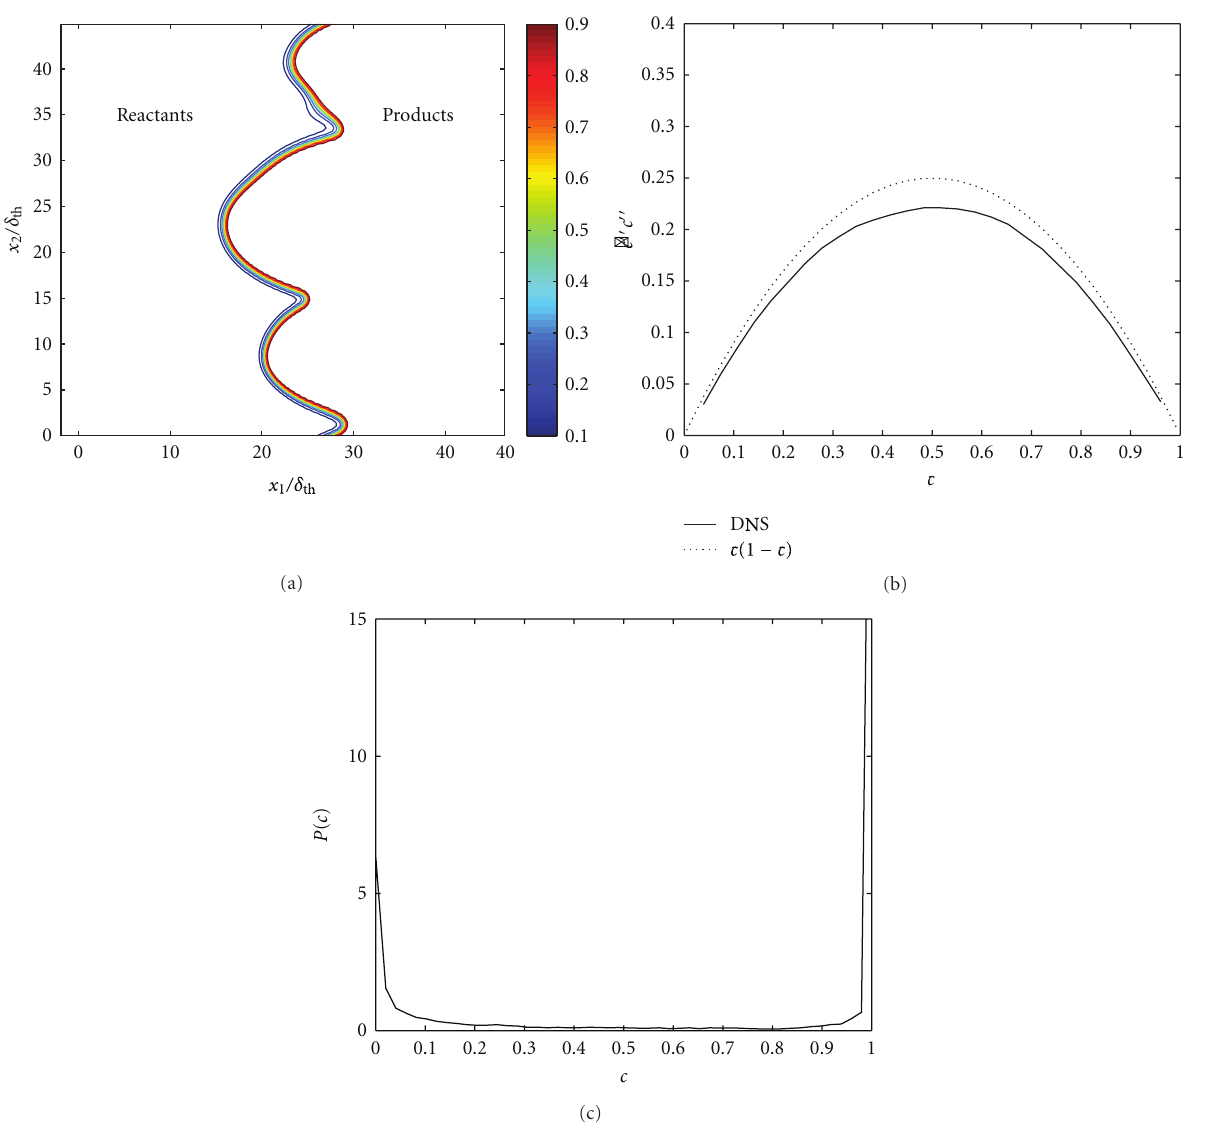
Figure 1: (a) Contours of reaction progress variable c for c = 0 . 1–0 . 9 (left to right) in steps of 0.1 at the x 1 - x 2 mid-plane. (b) Variations of (cid:18) c (cid:2)(cid:2) 2 with (cid:2) c across the flame brush. (c) Pdfs of c at the location corresponding to (cid:2) c = 0 .